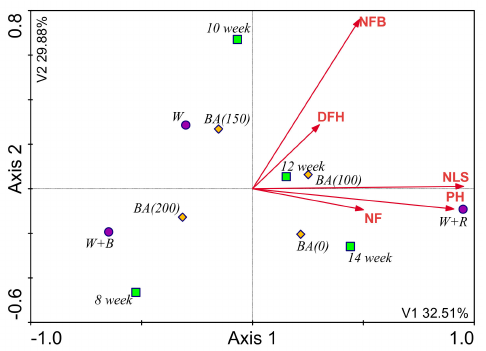
Figure 2. CCA analysis ( n = 48)—relationships between the morphological parameters of